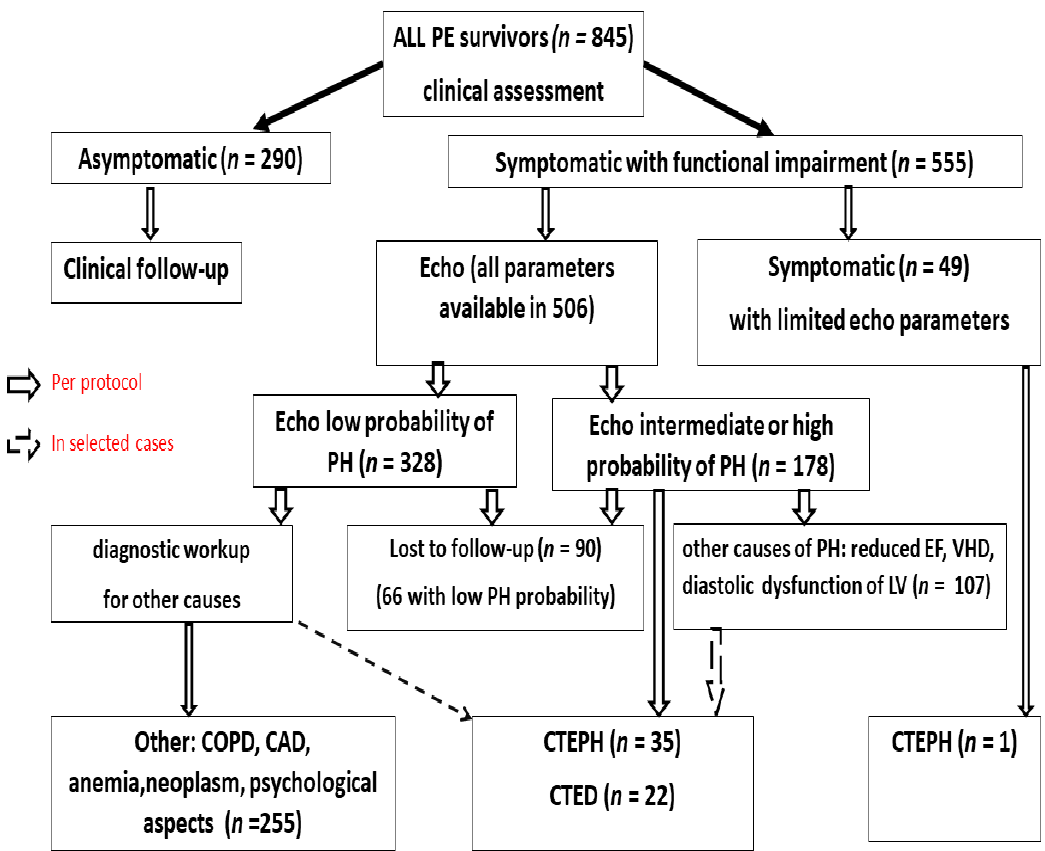
Figure 1. Follow up study of PE survivors. PE — pulmonary embolism, PH — pulmonary hypertension, CTEPH — chronic thromboembolism pulmonary hypertension, CTED — chronic thrombo-embolic disease, EF — ejection fraction, LV — left ventricular, COPD — chronic obstructive pulmonary disease, CAD — coronary artery disease, VHD — valvular heart disease.